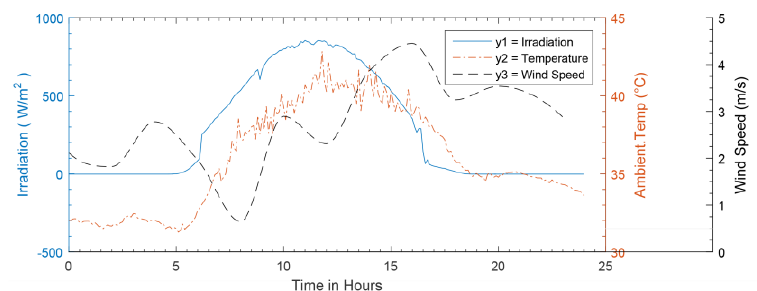
Figure 12. Output of FLEMS.